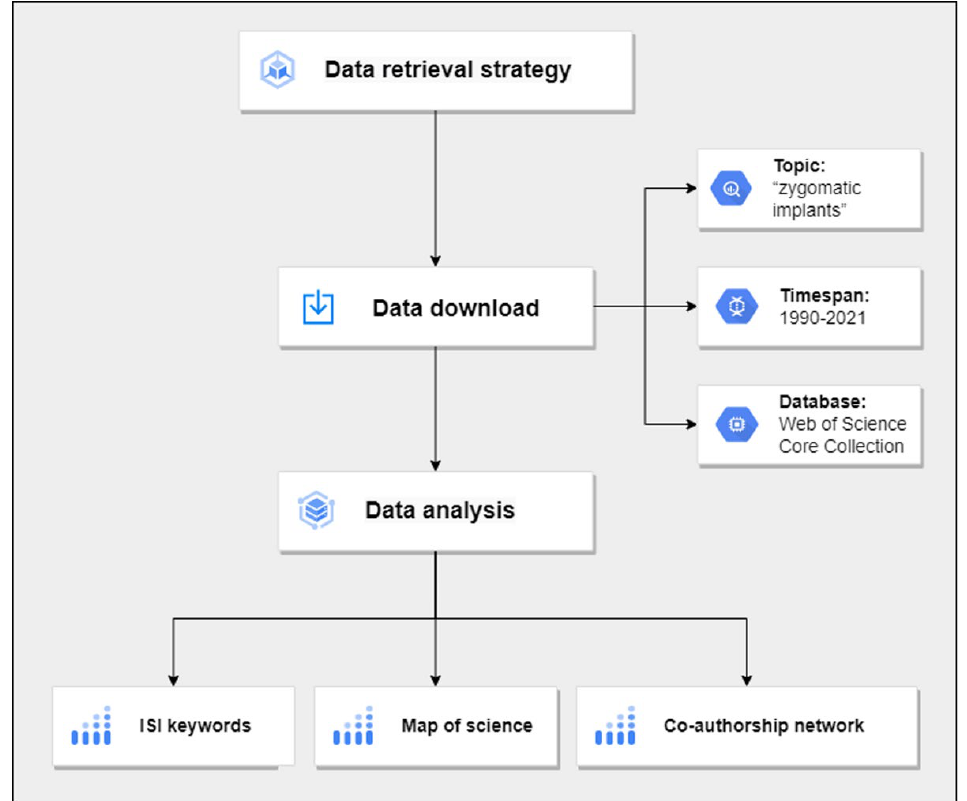
Figure 1. Experimental design of the study. The flowchart illustrates the step followed from data collection to data